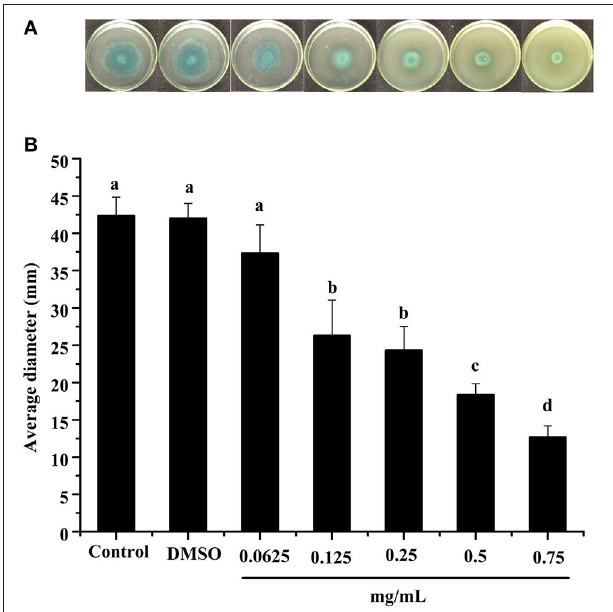
FIGURE 5 | Effects of the dichloromethane fraction (0.75 mg/mL) of the Camellia nitidissima Chi flowers on gene expressions of QS regulatory circuits in Pseudomonas aeruginosa PAO1. Average relative amounts of tested genes were normalized to the average relative amount of the rpsL reference gene. * p < 0.05; ** p < 0.01.